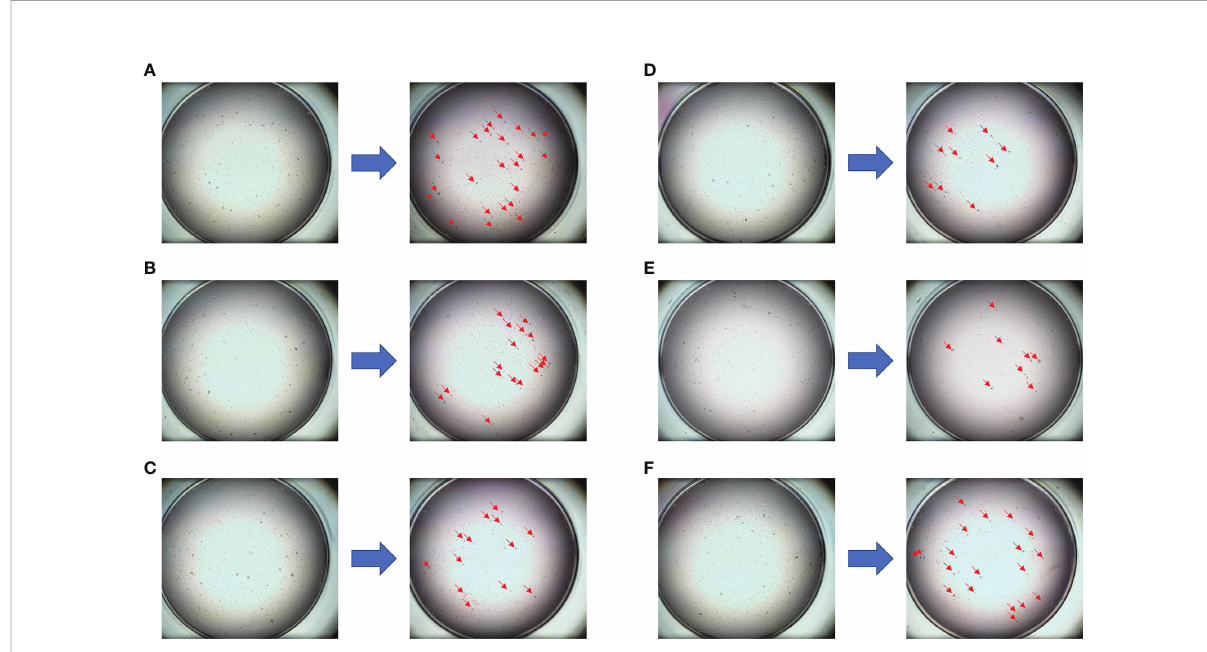
FIGURE 3 The drug sensitivity results of the PTC model for individualized treatment in case 1. (A) Comparison of trastuzumab before and after dosing; (B) comparison of epirubicin + cyclophosphamide before and after dosing; (C) comparison of vinorelbine + capecitabine before and after dosing; (D) comparison of albumin paclitaxel + capecitabine before and after dosing; (E) comparison of albumin paclitaxel + carboplatin before and after dosing; (F) negative control (NC)